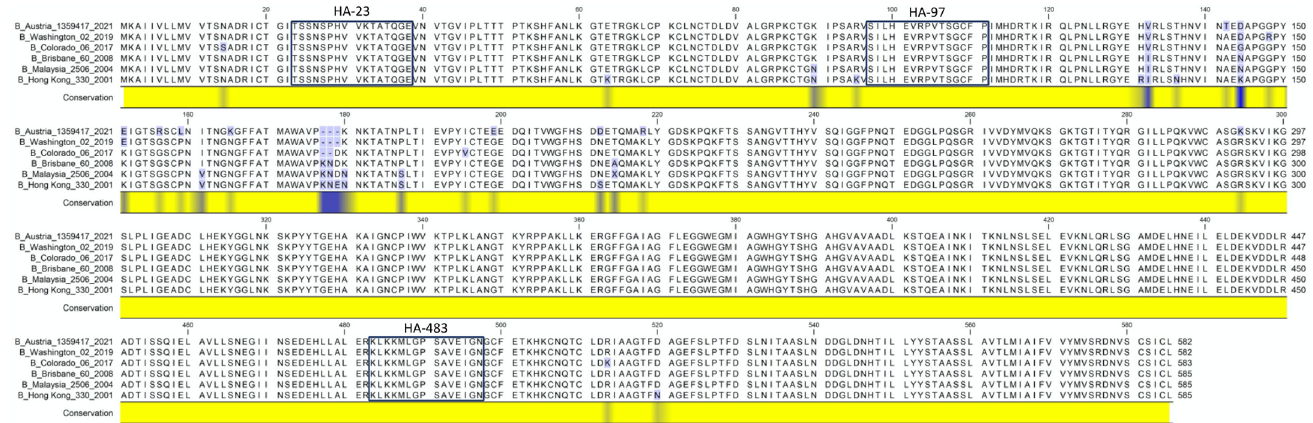
Figure 1. Influenza B HA sequences from the Victoria lineage that have been included in seasonal influenza vaccines over the past 20 years have been aligned to indicate sequence conservation. Yellow indicates conserved regions and blue indicates divergent amino acids. Indicated in the boxes are the three dominant CD4 T cells peptide epitopes. The sequence accession numbers are: B/Washington/02/2019 QCG86180, B/Colorado/06/2017 ARQ85589, B/Brisbane/60/2008 ANC28539, B/Malaysia/2506/2004ACR15732 and B/Hong Kong/330/2001 ABL77178.